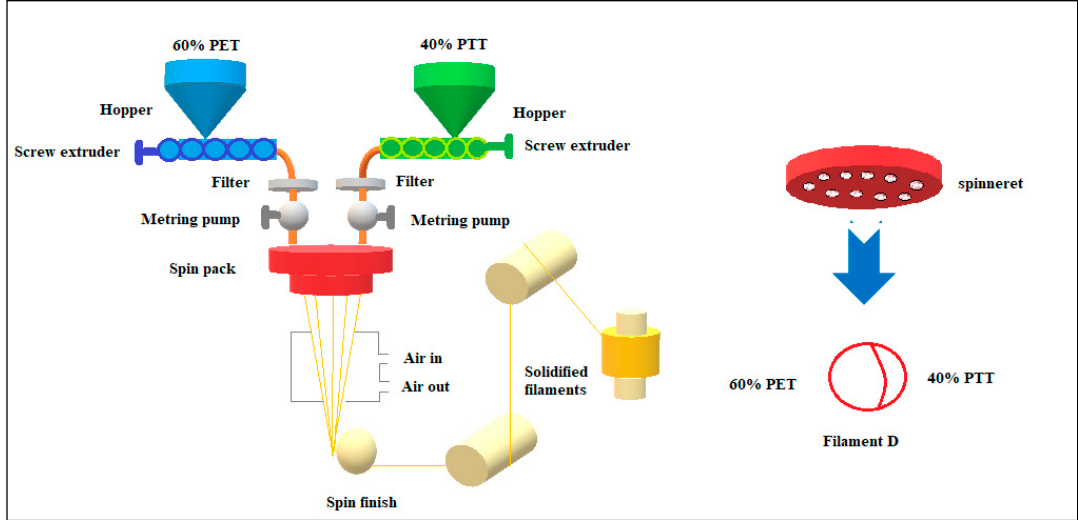
Figure 1. Spinning process of bicomponent filaments using side by side configuration.